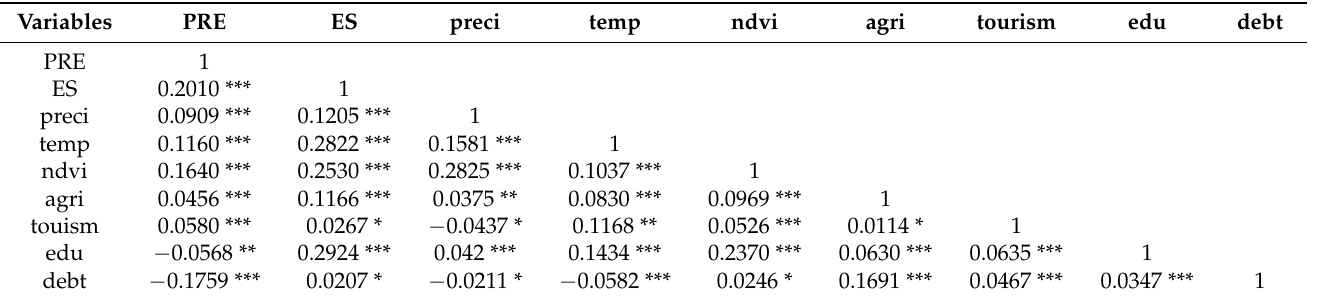
Table A3. Coefficients in the panel